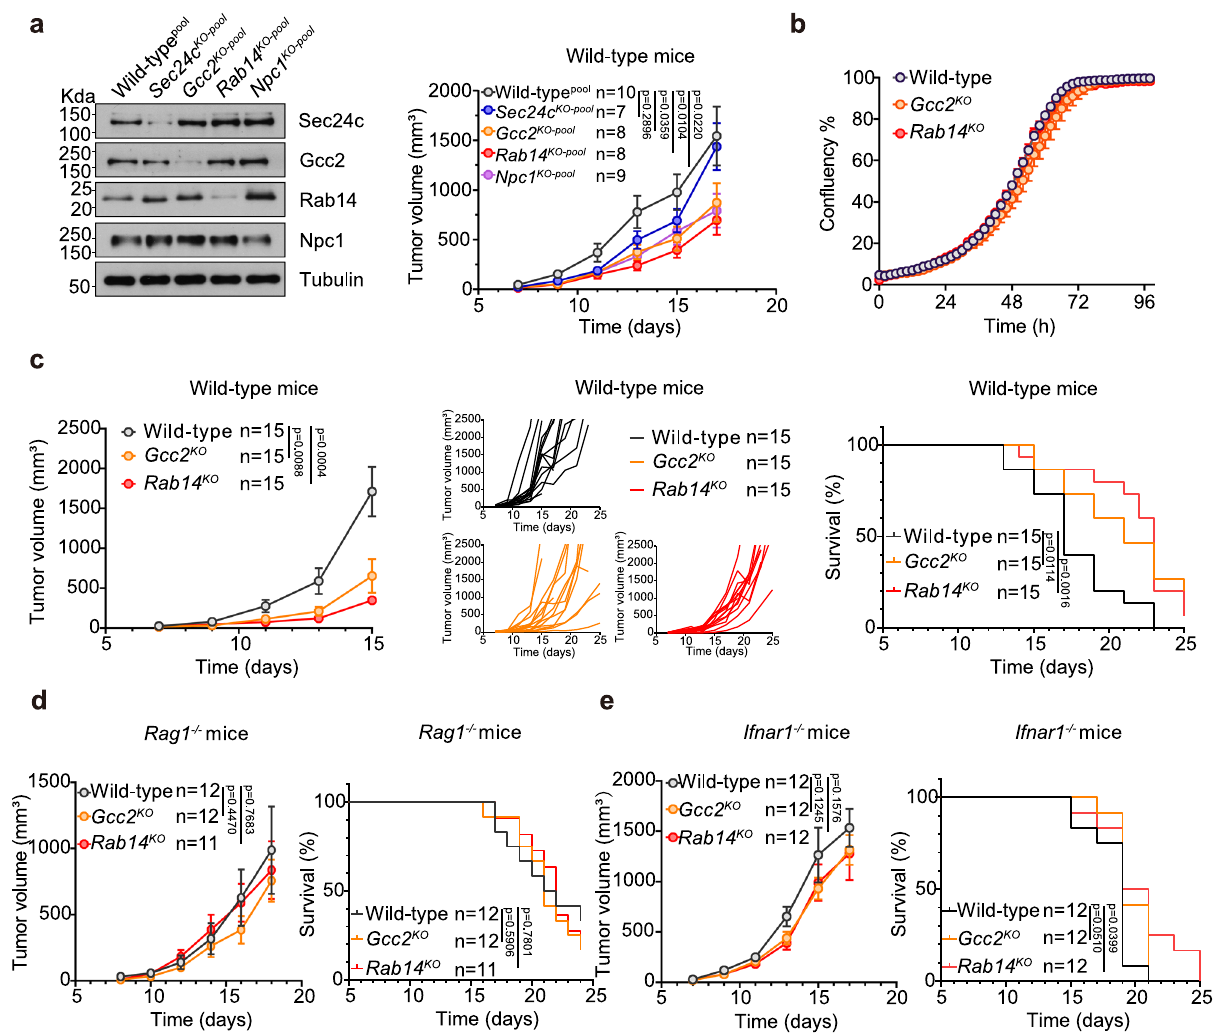
Fig.8|Gcc2-KOandRab14-KOinduceanti-tumorimmunity.a B16tumorgrowth in wild-typemice.Left,Westernblotanalysis of CRISPR/Cas9knockoutpooledB16 cells. Right, tumor volumes of wild-type pool , Sec24 KO-pool , Gcc2 KO-pool , Rab14 KO-pool , or Npc1 KO-pool B16 melanoma cells after subcutaneous injection in wild-type mice. b Wild-type, Gcc2 KO and Rab14 KO B16 cell proliferation analysis by IncuCyte. Representative single-cell CRISPR/Cas9 knockout clones are shown. c Wild-type, Gcc2 KO and Rab14 KO B16 tumorgrowth in wild-typemice. Left, meantumorvolume.